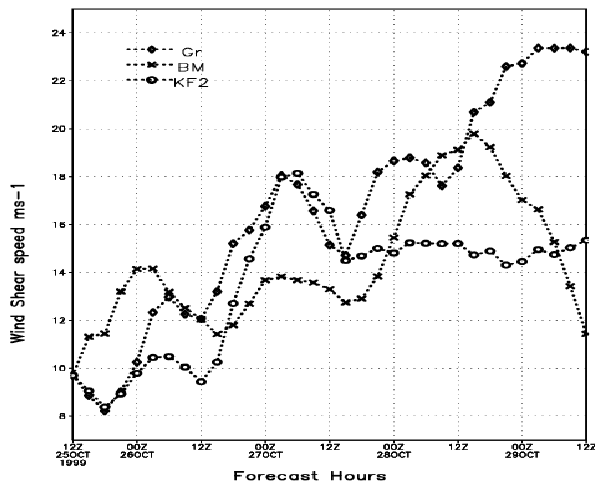
Time series from 0 to 96h of integration (that is from 12:00UTC, 25 to 12:00UTC, 29 October 1999) of domain- averaged vertical wind shear (ms − 1 ) of horizontal wind between 850 and 200hPa